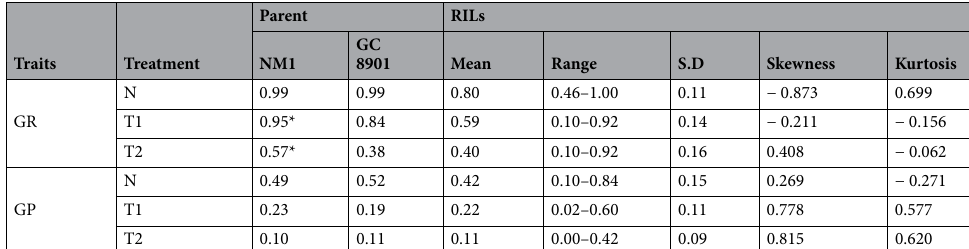
Table 1. Phenotypic performance for germination rate and germination potential of the two parents and RIL population under different salt treatments. GR, germination rate; GP, germination potential; N, 0 mM NaCl;